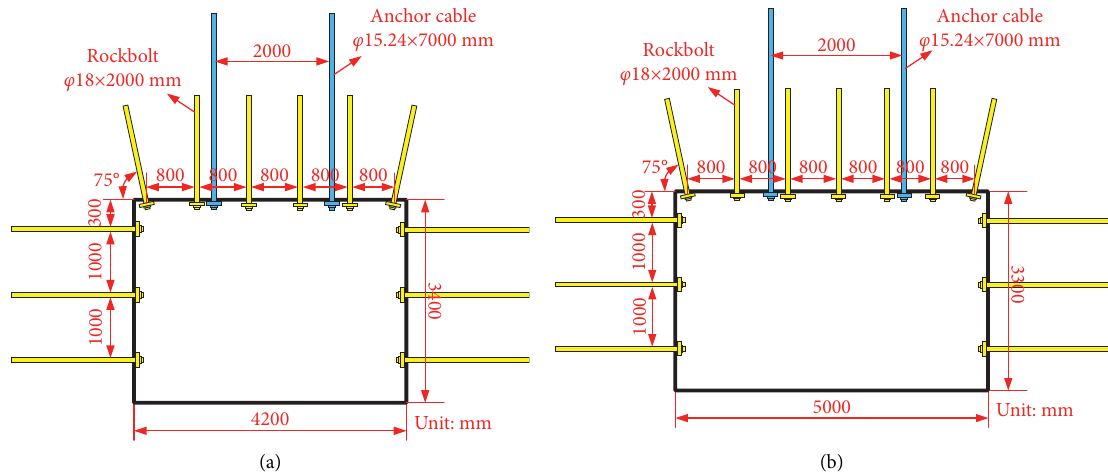
Figure 2: Support schemes of the roadway supports. (a) 5216 roadway. (b) 2216